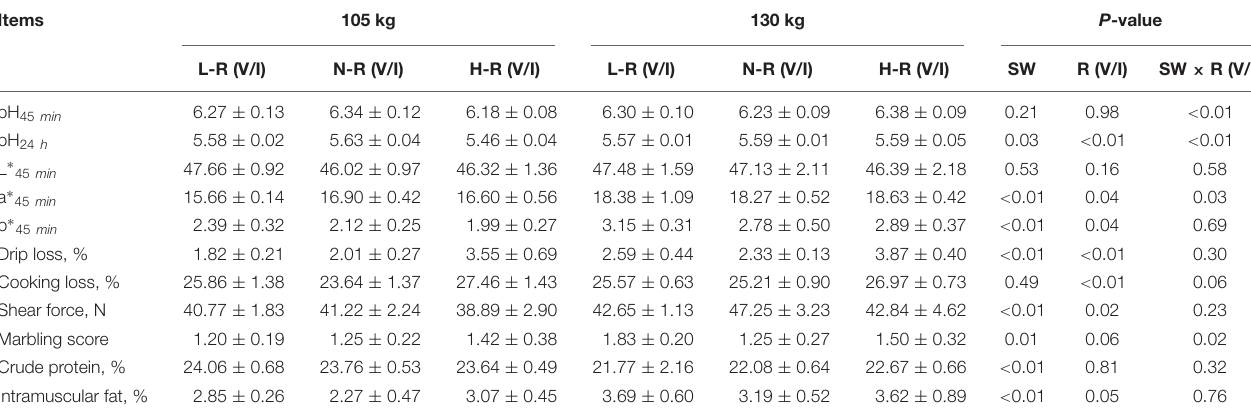
TABLE 3 | Effect of dietary R (V/I) and slaughter weight on the meat quality and proximate analysis of longissimus dorsi in finishing pigs ( n = 6).